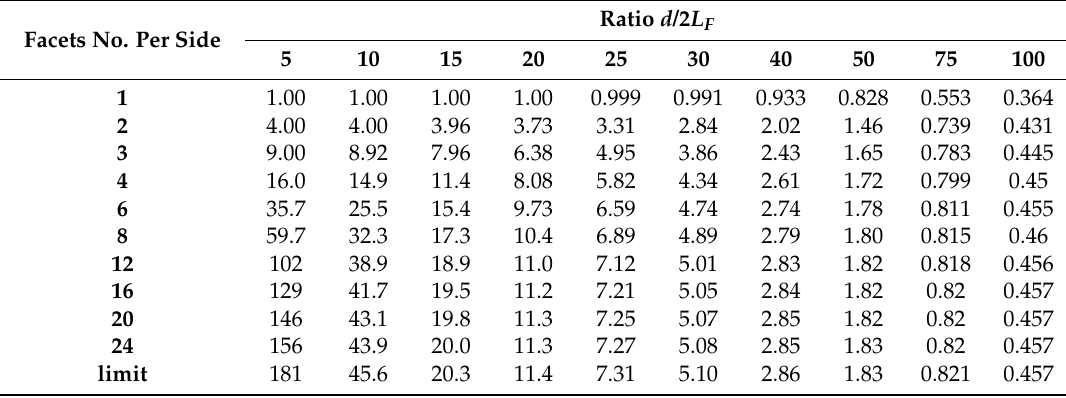
Table 1. Irradiance on the center of the target ( E SUN = 1), where d is the heliostat-target distance and 2 L F is the length of the heliostat side; the limit is calculated by means of the Lagrange invariance.